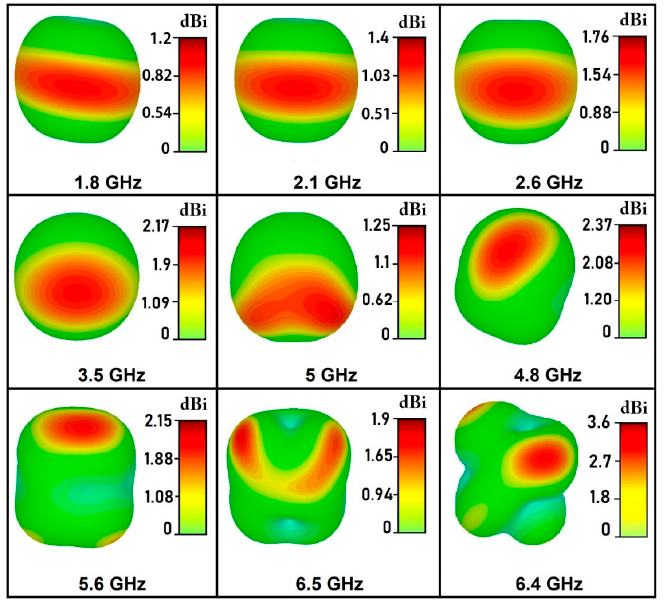
Figure 11. The three-dimensional plots of gain